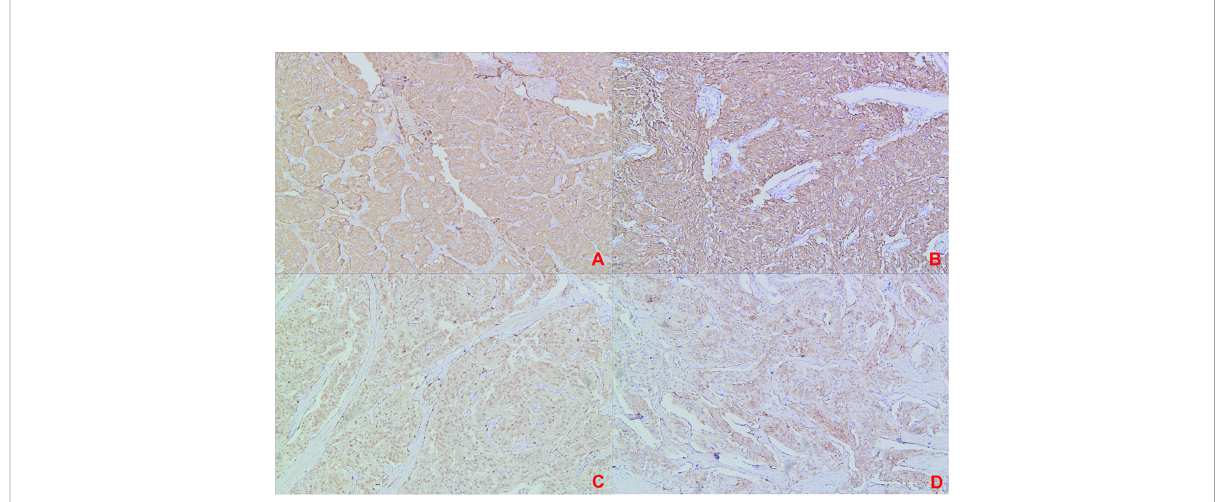
FIGURE 6 (Recurrence Treatment)Immunohistochemical staining: (A) Immunohistochemical staining CgA(+); (B) Immunohistochemical staining SYN(+); (C) Immunohistochemical staining S-100(+); (D) Immunohistochemical staining SSTR2 (+).